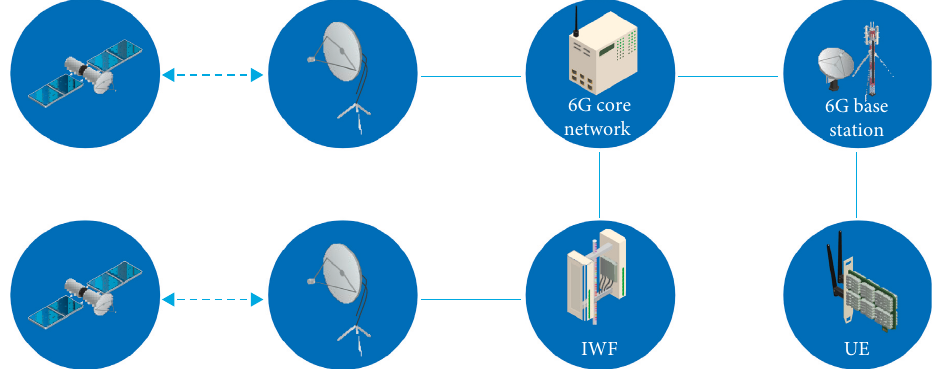
Figure 1: High-precision target detection of remote sensing image enhanced by 6G technical